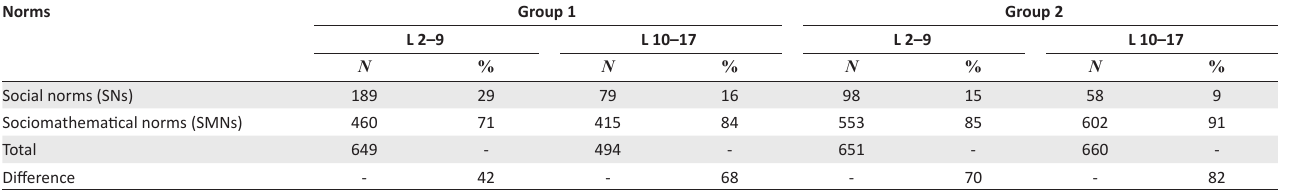
TABLE 2: Social norms and sociomathematical norms for groups 1 and 2 divided into first and second half of intervention.